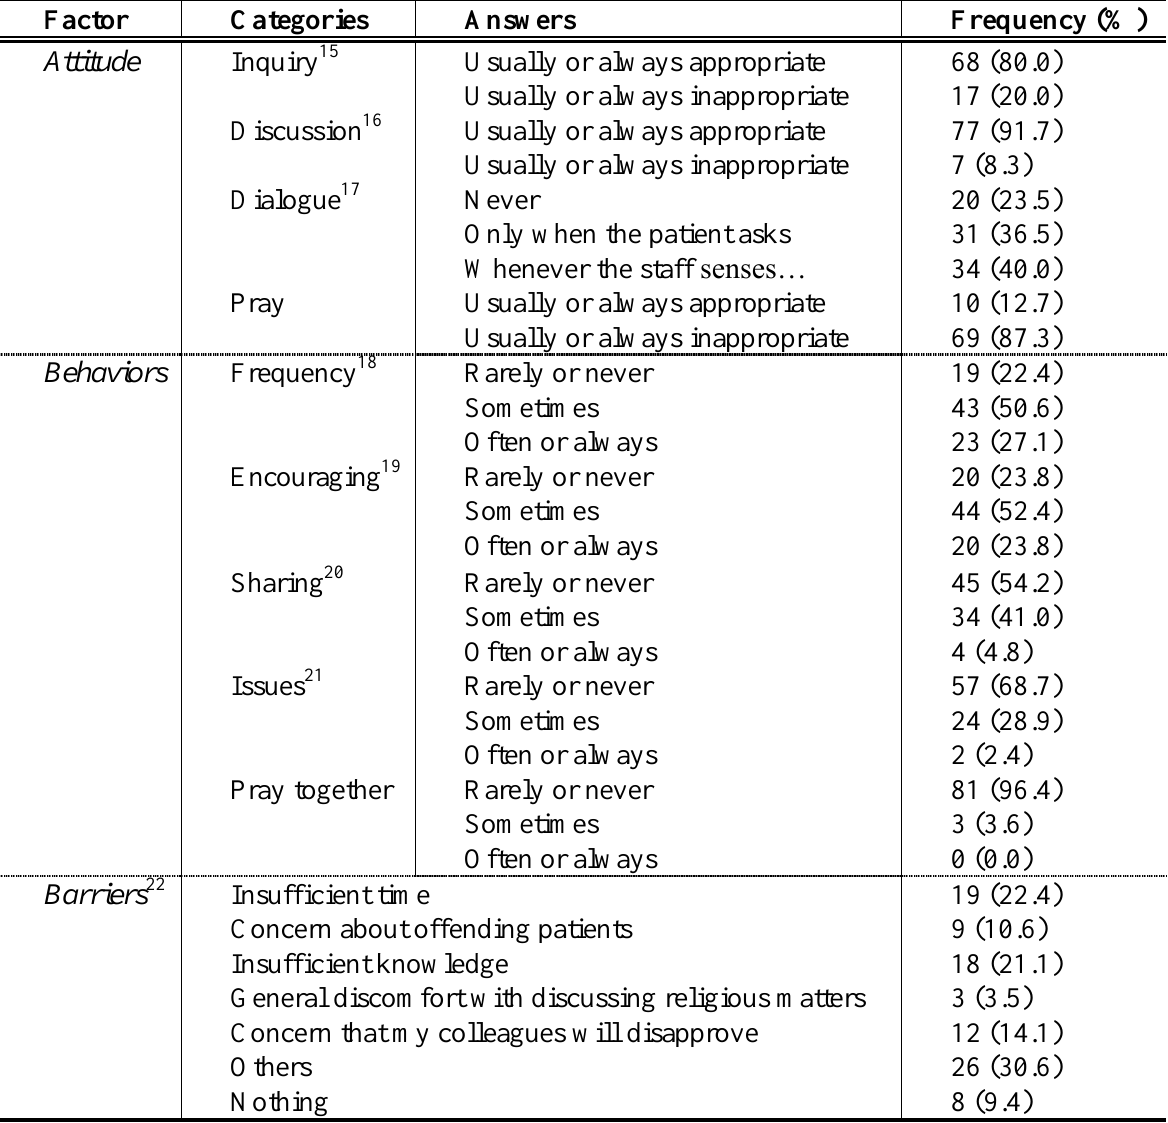
Table 4. Staff‟s point of view regarding the integration of religious/spiritual contents (N =